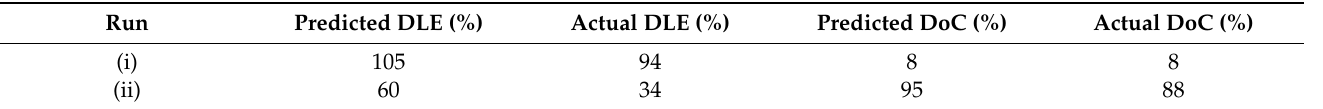
Table 4. Predicted values and actual results from carrying out the optimized spray coating runs using feed from the agitated bed